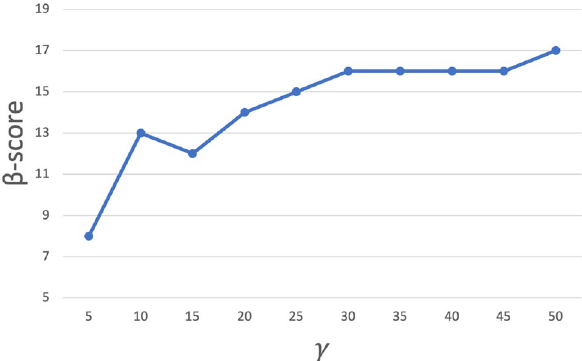
Figure 6. Graphic representation of the β -score for the results of Table 3, where the evolution as the cost ratio γ increases can be observed.